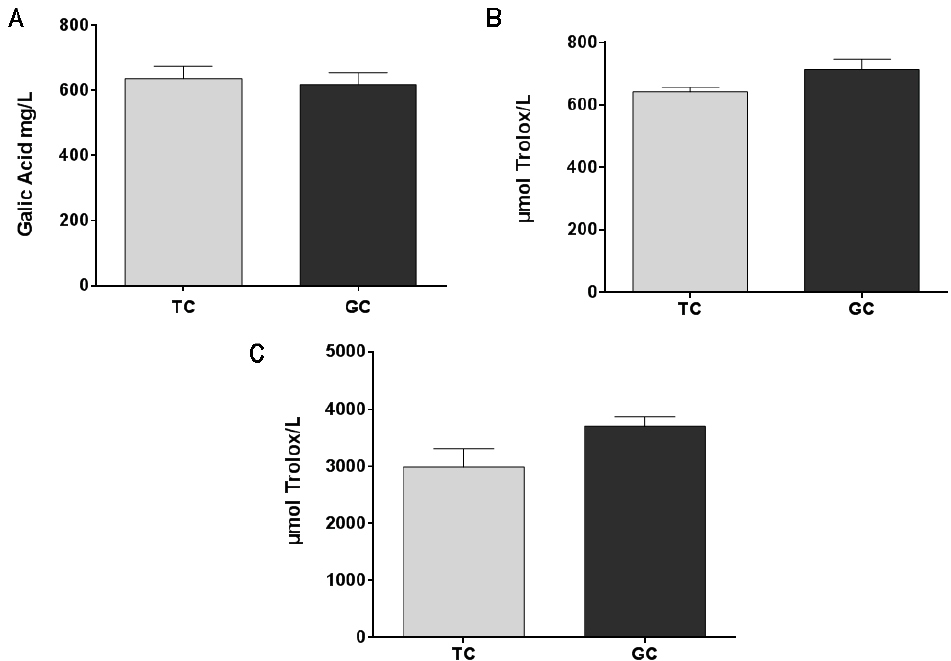
Figure 2. Total phenolic content ( A ) in green coffee extract (GC) and toasted coffee extract (TC) (results are expressed as gallic acid mg/L). Antioxidant capacity was measured by the DPPH Radical Scavenging capacity method ( B ) and by the FRAP method ( C ). Results are expressed as mol Trolox equivalent/L.